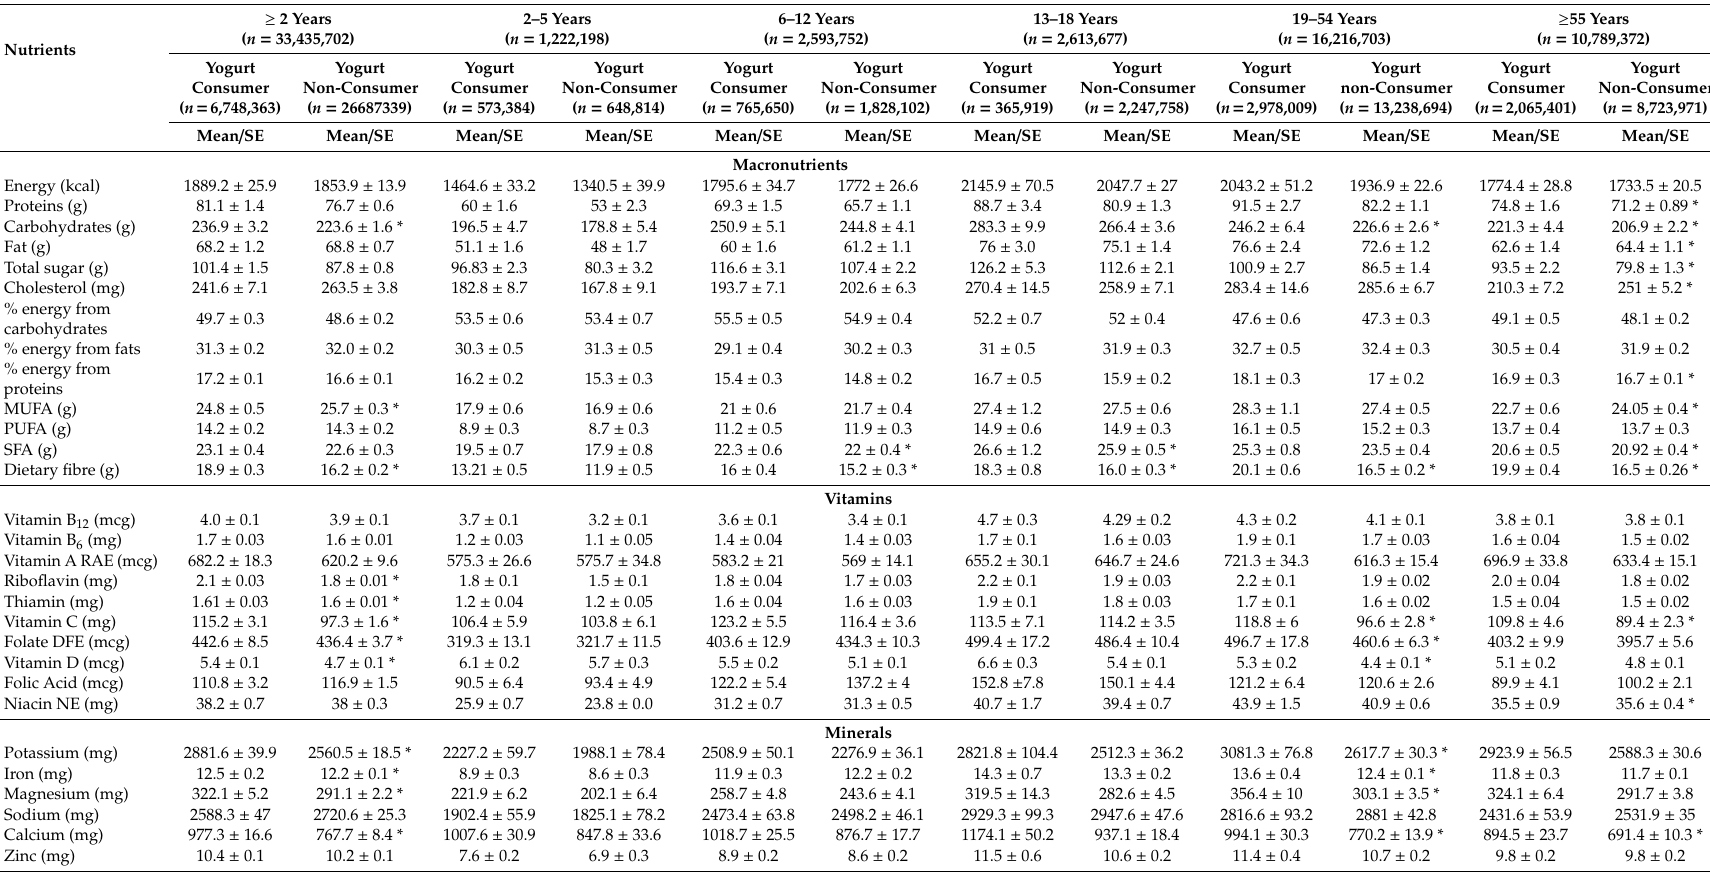
Table 3. Daily energy and nutrients intake between yogurt consumers and non-consumers, all ages and by five age groups 1 .